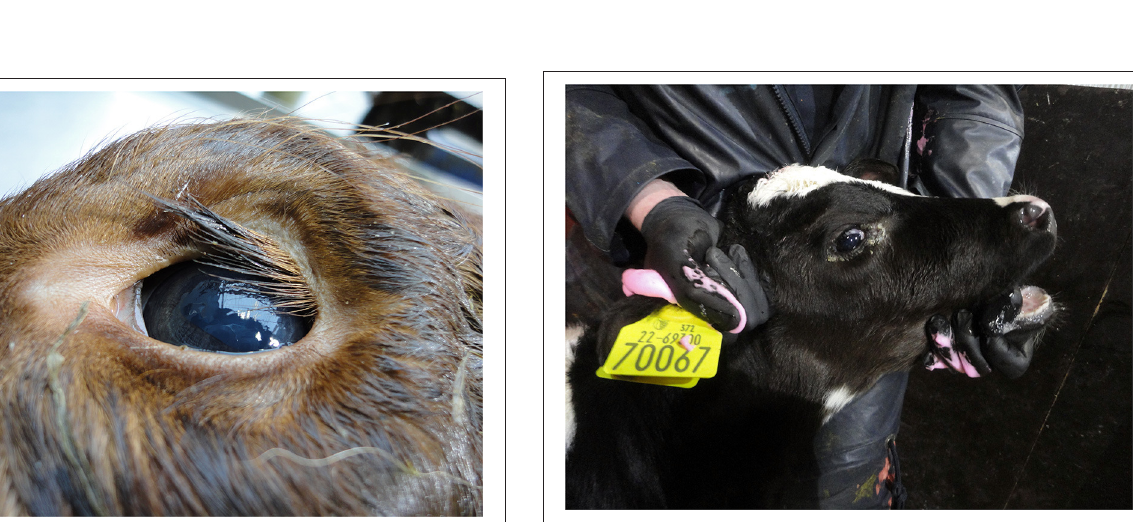
FIGURE 4 | Enophthalmos (sunken eye) in a calf with dehydration.